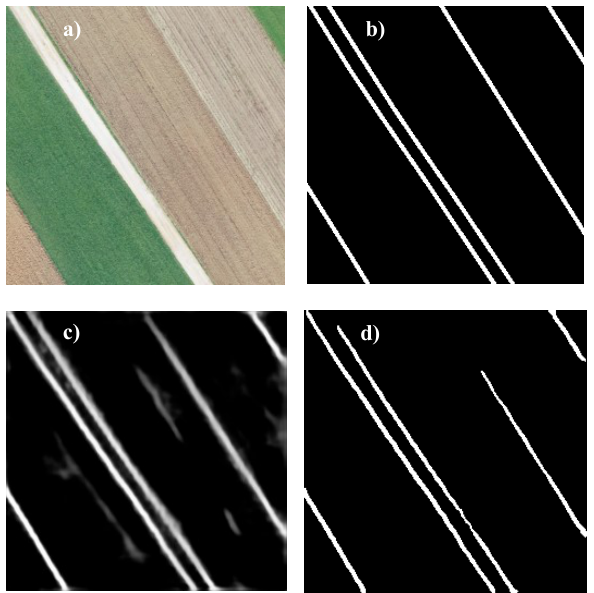
Figure 5. Predictions of the trained model based on U-Net. (a) Example 2 of tiled UAV image. (b) ground truth boundaries. (c)